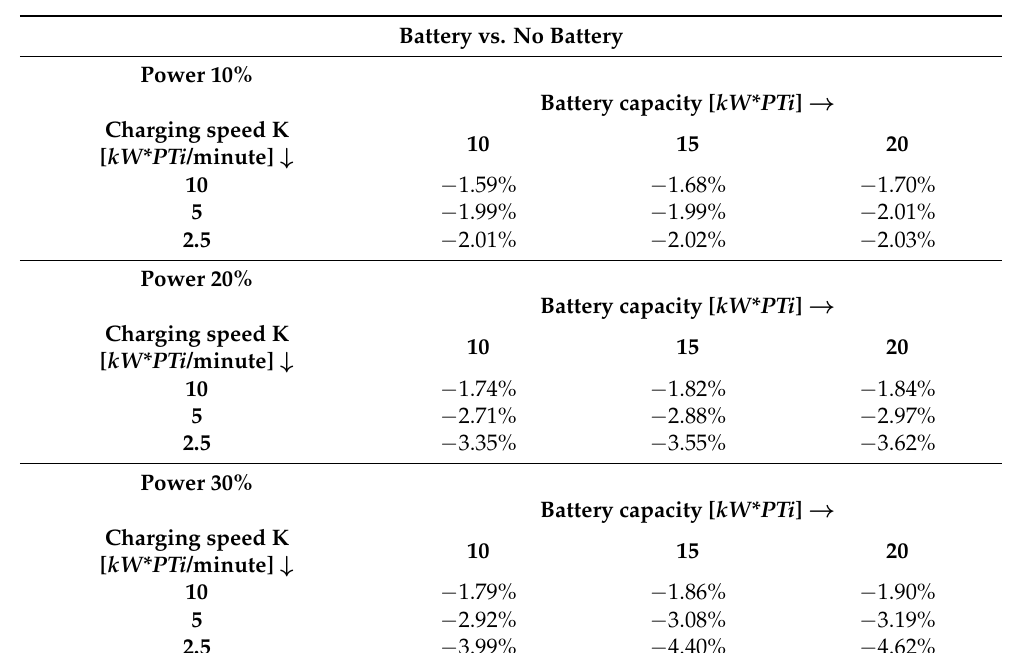
Table 4. Average use of electricity grid.